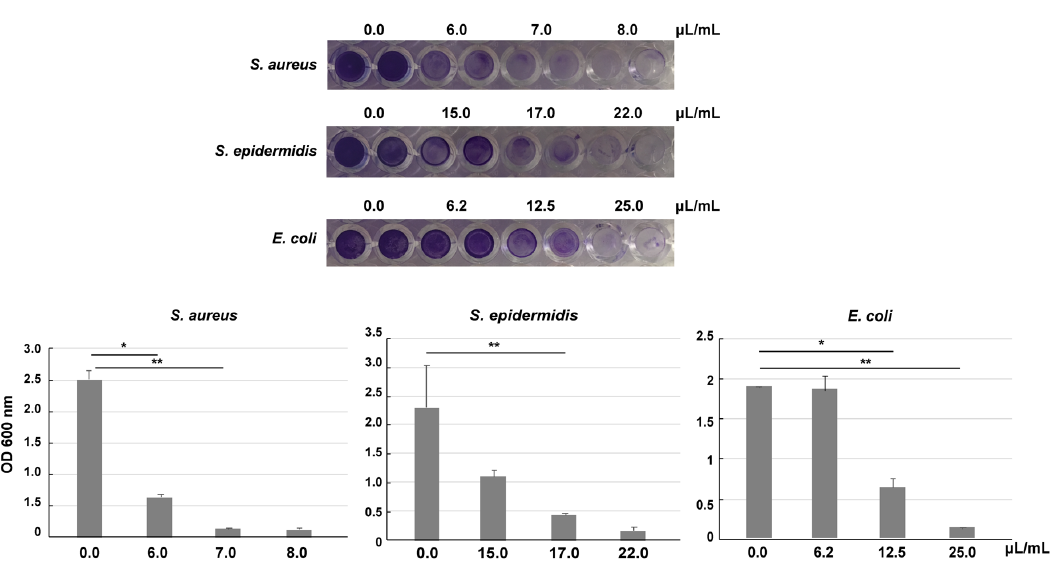
Figure 2. Inhibition of biofilm formation by VE-TPGS CHX formulation. S. aureus, S. epidermidis and E. coli were grown for 24 h in presence of different dilutions of the formulation. Biofilms were stained by crystal violet, dissolved and measured at 600 nm. The results are expressed as mean ± SEM. * p ≤ 0.05, ** p ≤ 0.01, the data were analyzed by student's t -test.